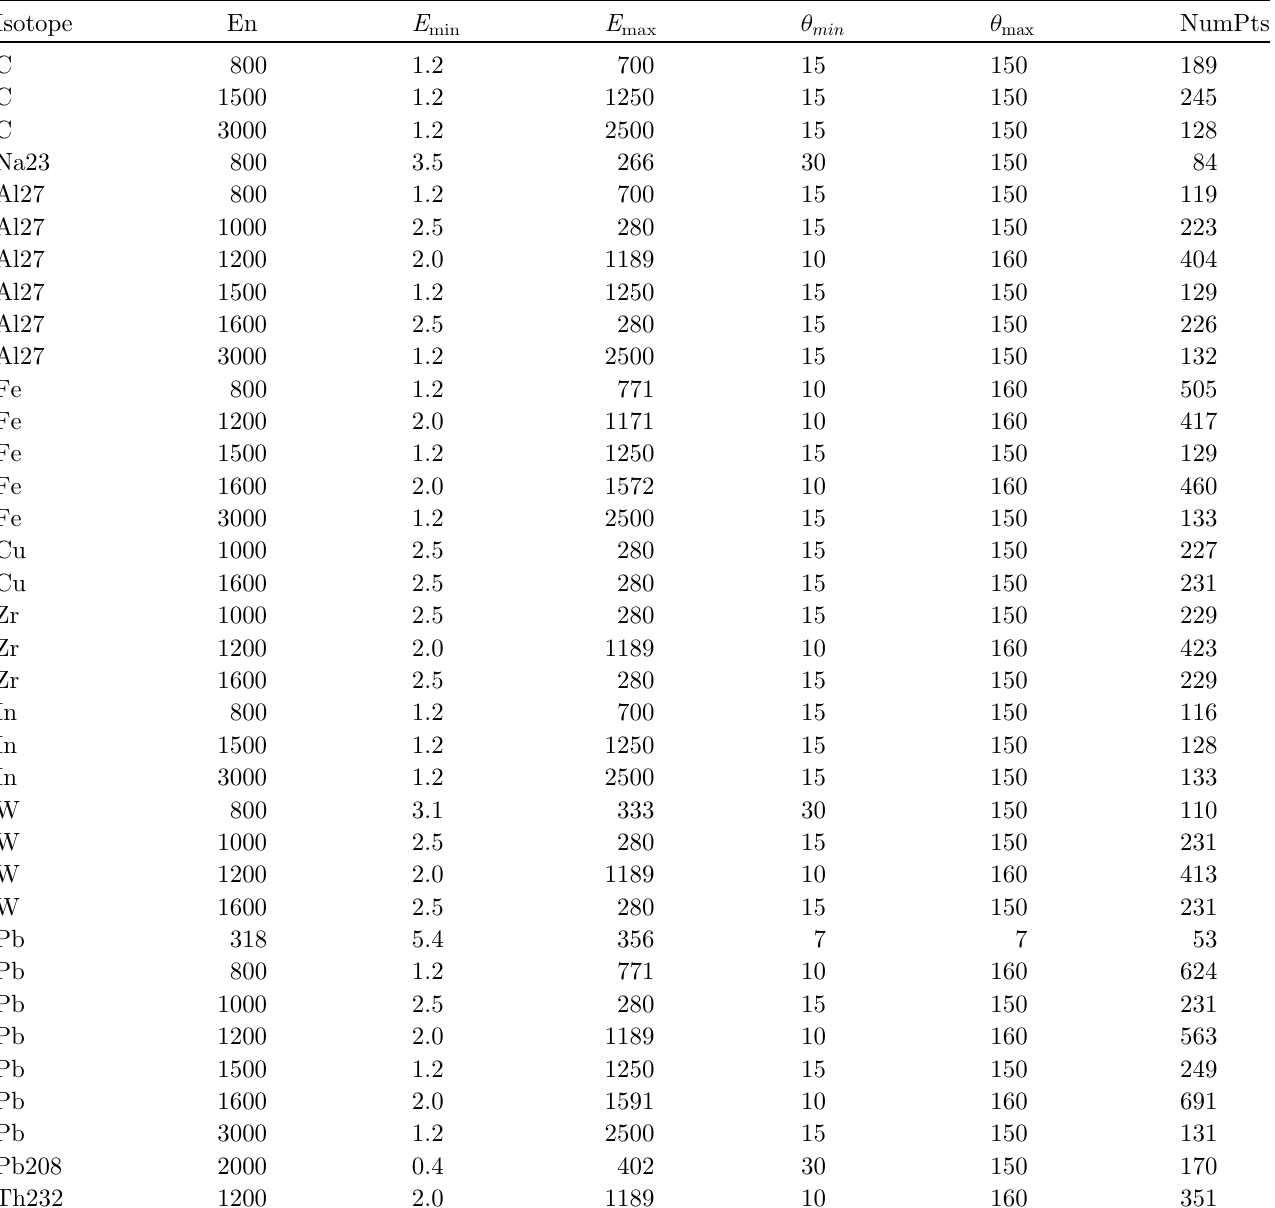
Table 1. Summary of the double-differential ( p , X ) n data above 100 MeV incident energy found in EXFOR [10]. No mass number is appended to the isotope name in the case of natural composition. Columns are: incident proton energy (En), , E ), range of emission angles ( u , u ), and number of data points (NumPts). range of emitted neutron energy ( E min max min max Energy related columns are in MeV and angles in degree. The total number of data points is